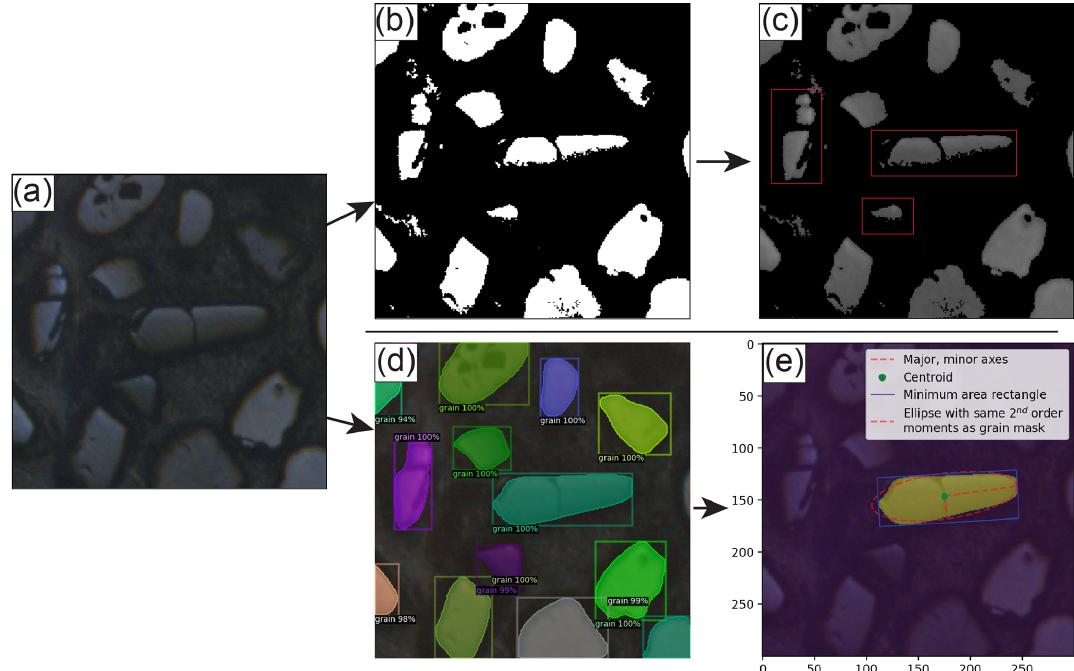
Figure 1. Visualizations of image thresholding segmentation using Otsu’s method (Otsu, 1979) and its inherent problems in the context of reflected light detrital zircon grain images (top row) and of the colab_zirc_dims segmentation and grain measurement process (bottom row). (a) An original, unaltered LA-ICP-MS reflected-light image. (b) A binary image resulting from segmentation of the original image into foreground (white) and background (black) classes using Otsu’s method. (c) The original image with “background” masked out using the binary image. Red highlights indicate single grains that have been erroneously eroded, segmented into multiple grains along fractures, or both. (d) The results (bounding boxes, probability scores, and masks) of instance segmentation of the original image using a Mask- RCNN model (M-ST-C; see Table B1), as displayed by the Detectron2 “visualizer” module. (e) The resulting colab_zirc_dims verification image, scaled in micrometres and displaying the identified central grain mask (yellow), mask centroid (green), minimum-area circumscribing rectangle (blue), and ellipse with the same second-order moments as the grain mask along with its axes